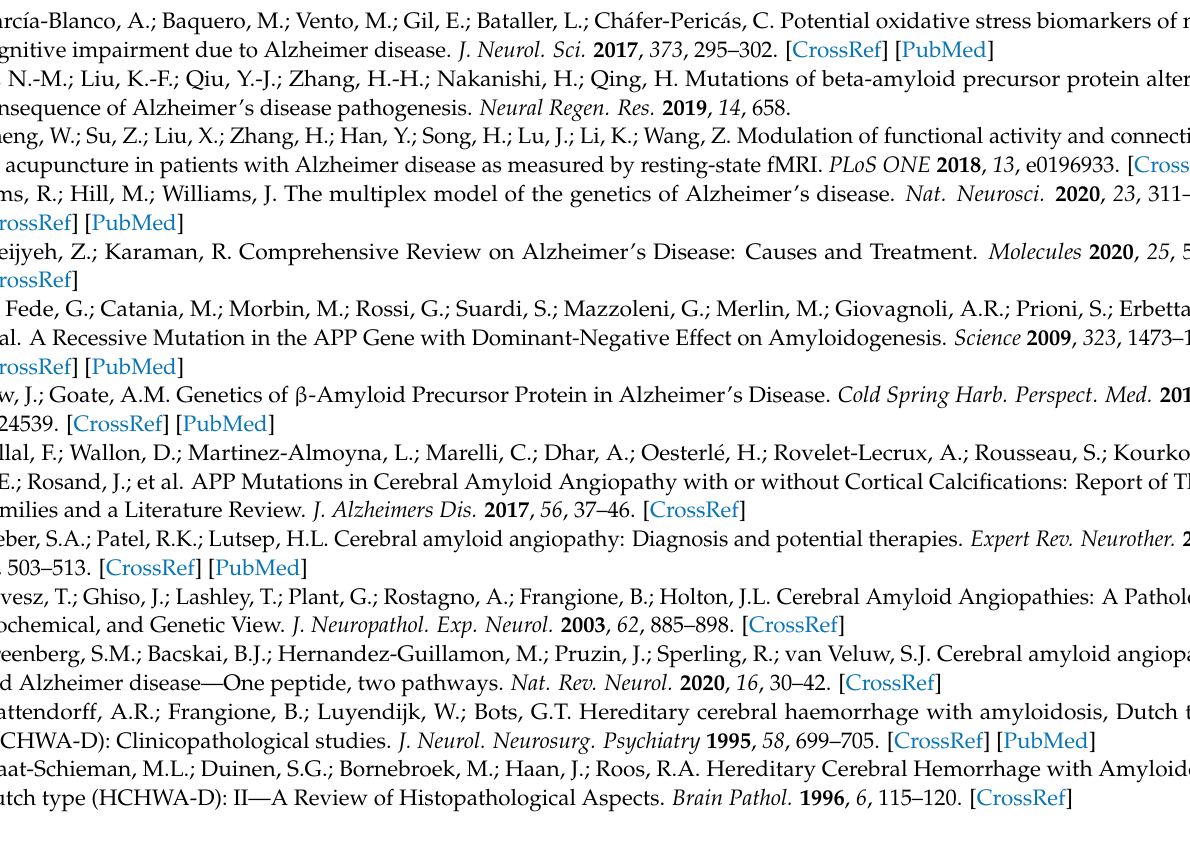
data. Figure S2: Heatmap of the CHROMOPAINTER coancestry matrix. Figure S3: Full dendrogram of the fineSTRUCTURE hierarchical clustering analysis. Figure S4: Scatterplot of the number of SNPs vs. bp size of observed regions along the genome shared among patients. Figure S5: tMRCA estimation for small windows. Table S1: Window size and SNP number